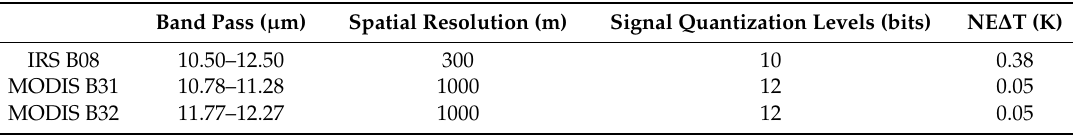
Table1. Comparisonofselectedthermalbandfeaturesoftheinfraredsensor(IRS)andmoderate-resolution imaging spectroradiometer